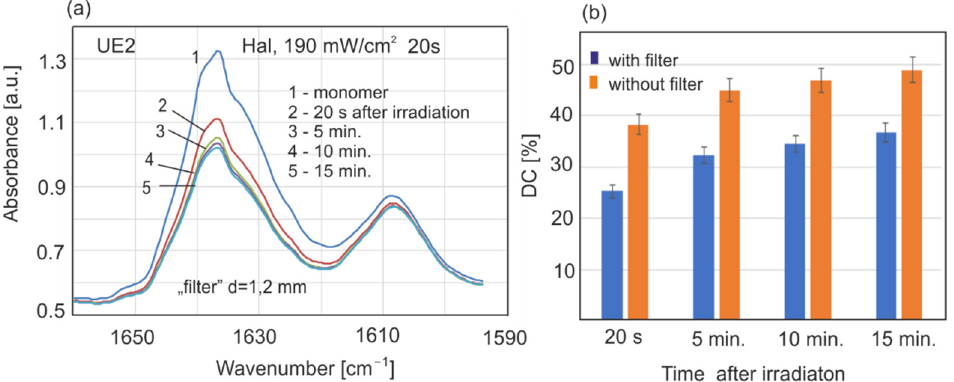
Figure 11. Absorption changes in the UE2 monomer spectrum ( a ), DC of the UE2 irradiated through a polymer ring with 1.2 mm thickness and without a filter ( b ).